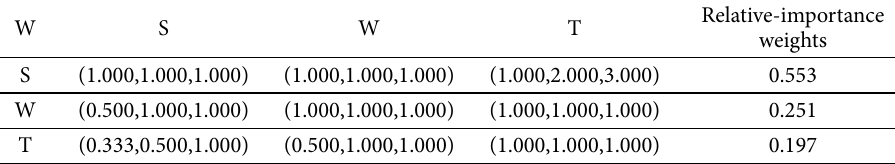
Table 5. The relative-importance weights for the “W”